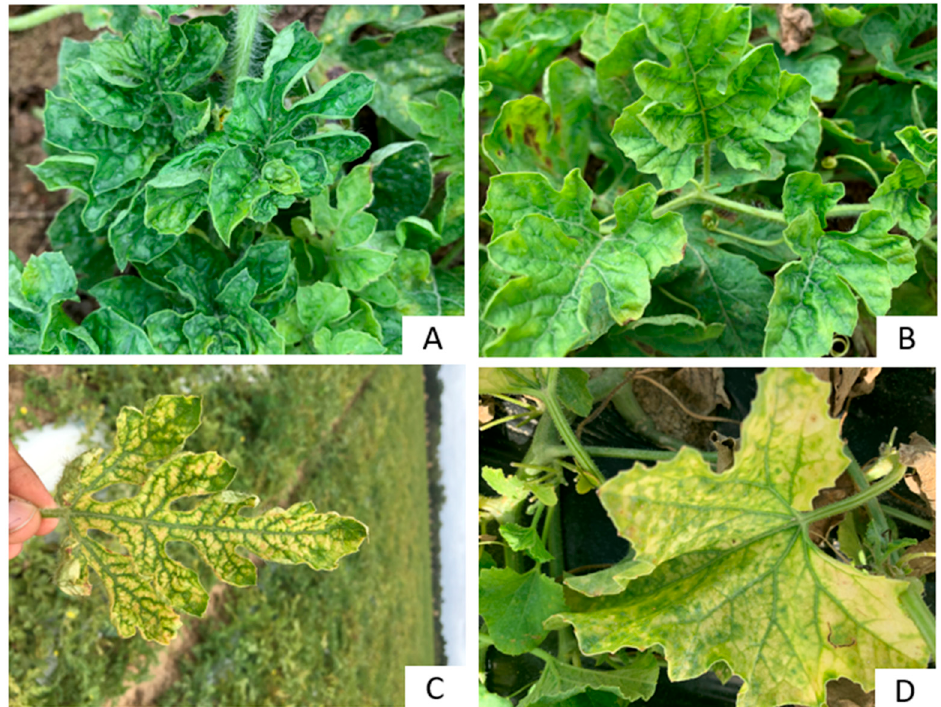
Figure 2. Symptoms observed on the field during the survey include: on watermelon ( A – C ), leaf crinkling and bunchy top with upward curling appearance of young leaves ( A ), crinkling of young leaves with mild yellowing ( B ), severe interveinal chlorosis of the leaf ( C ). On cantaloupe, yellowing and interveinal chlorosis on the older leaf ( D ). Watermelon ( A , B ) and cantaloupe ( D ) was collected in spring 2021 and watermelon ( C ) was collected in fall 2019.